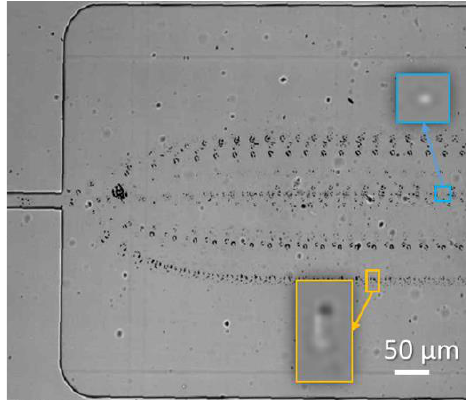
Fig. 3. Image stacked picture of chromosomes, suspended in 9000 ppm PBS/PEO 600kDa at 720 µL/h flow rate. The inserted images are the single-frame snapshots (7 times enlarged) from high-speed camera video recordings showing the location of 2.5 µm (blue outline) and 8.1 µm (yellow outline) size